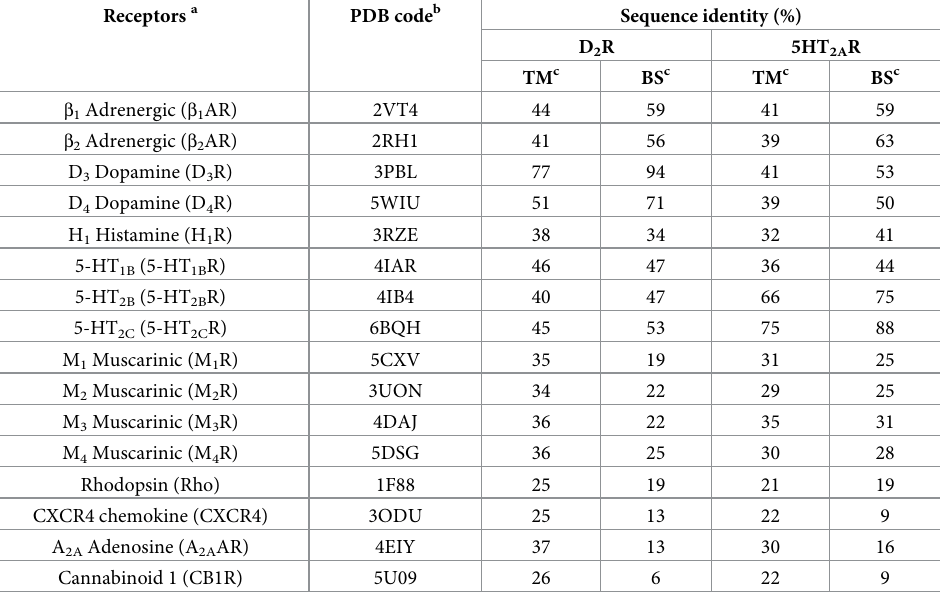
Table 1. Crystal structures selected as templates for homology modeling of the D 2 R and 5-HT 2A R. Receptors a PDB code b Sequence identity (%)